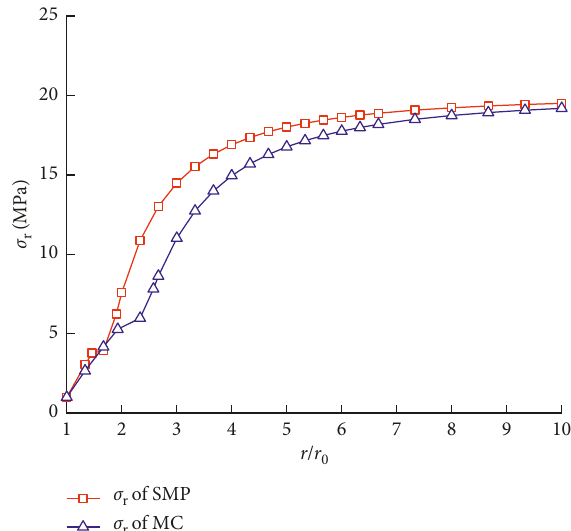
Figure 7: Surrounding rock tangential stress distribution of the Mohr–Coulomb and SMP criteria.